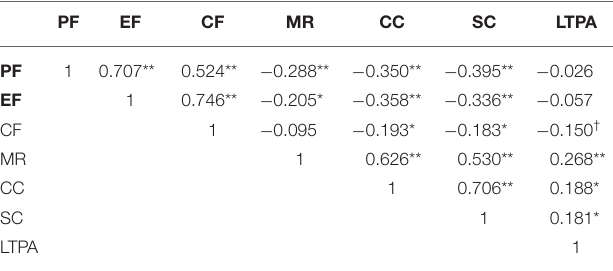
TABLE 3 | Correlation matrix of the latent factors and LTPA.